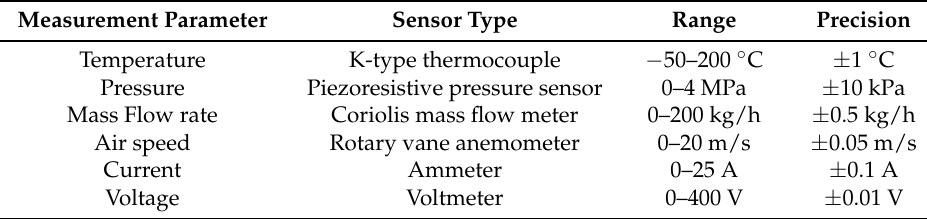
Table 2. Transducer type and precision.